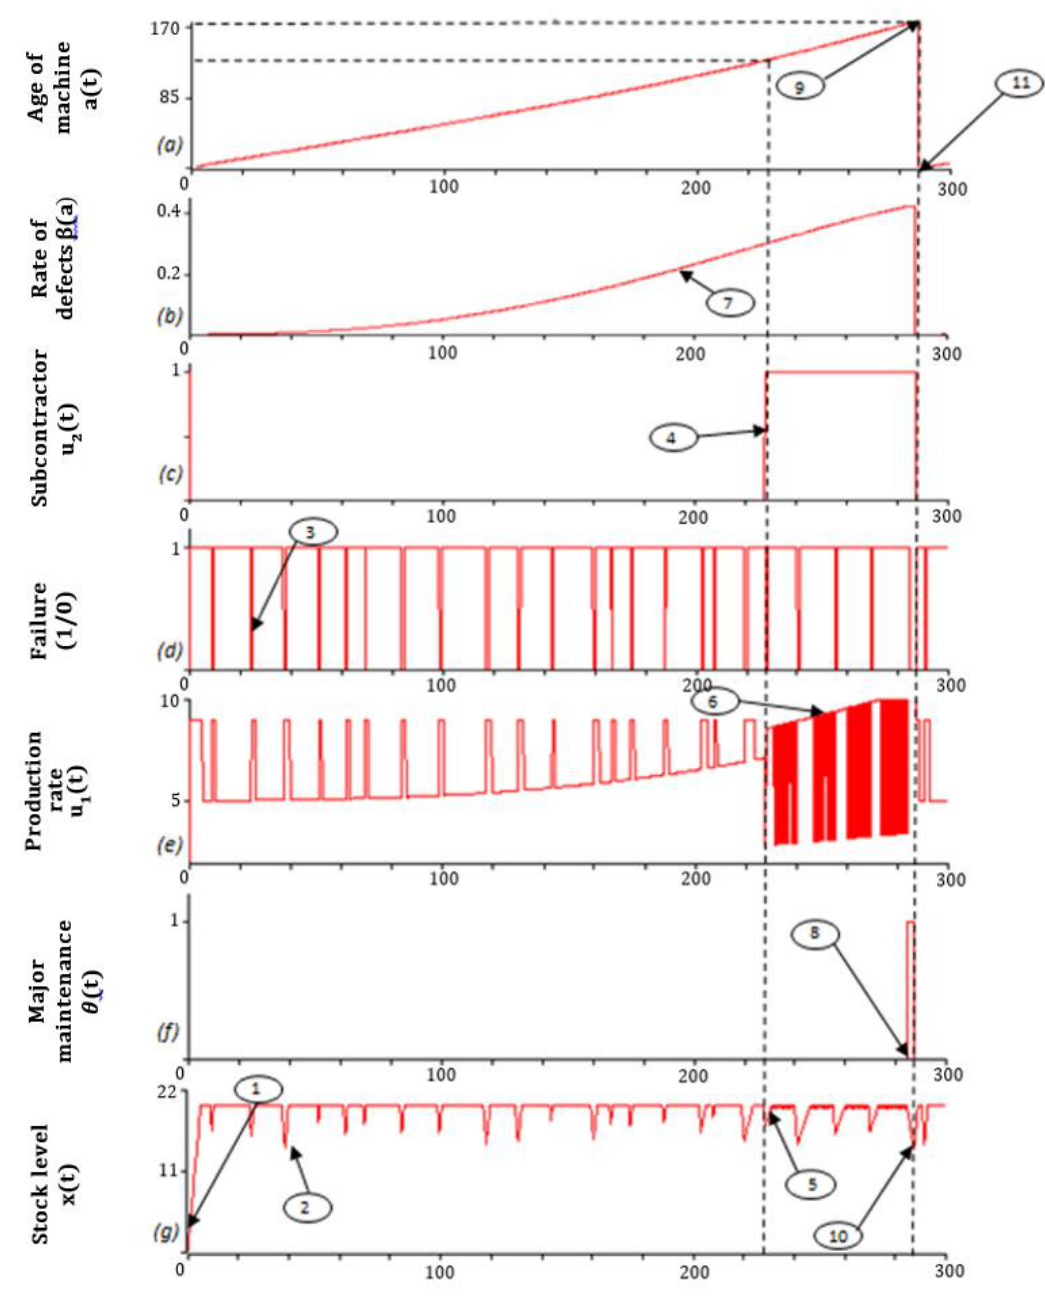
Figure 4. Simulation model validity.